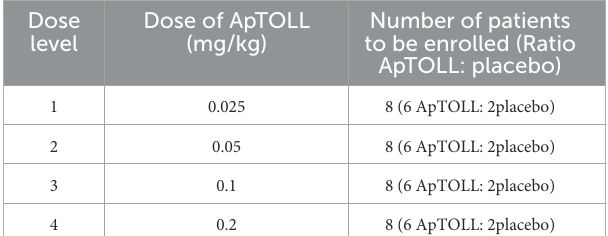
TABLE 1 Dose escalation in Phase Ib. Dose Dose of ApTOLL level